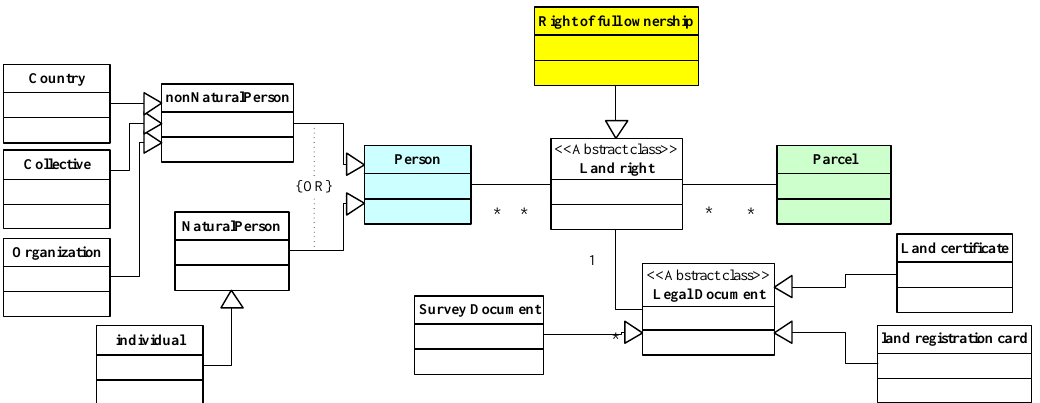
Figure 9. Person class of cadastral domain model